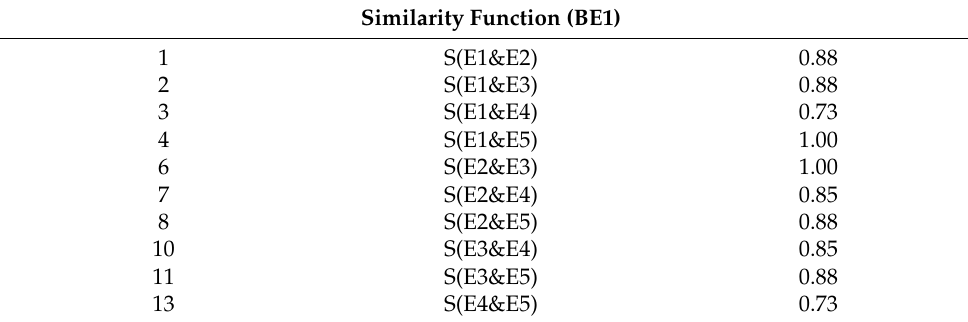
Table 7. Similarity function values of each pair of experts for BE1.